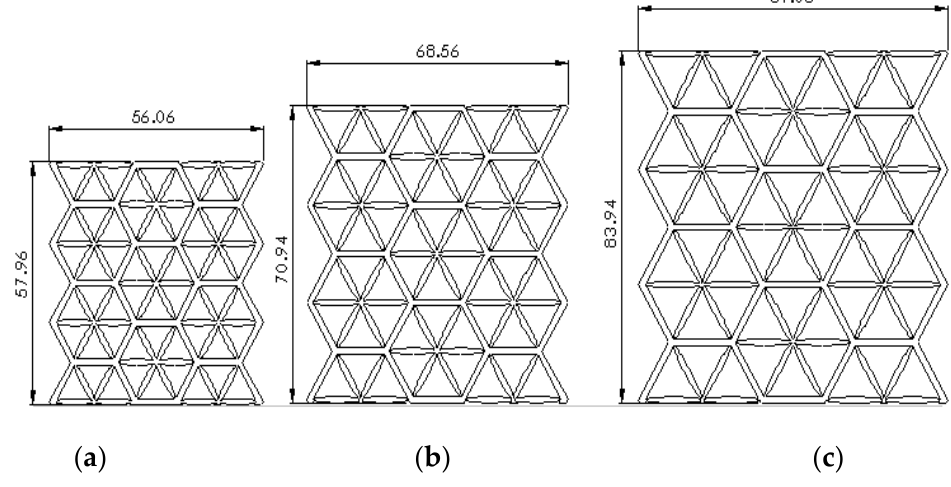
where F ave is the average load in the plateau region and F max is the maximum peak load. Figure 2. Illustration of honeycomb reinforced starfish structure. Figure 2. Illustration of honeycomb reinforced starfish structure. Figure 2. Illustration of honeycomb reinforced starfish structure.